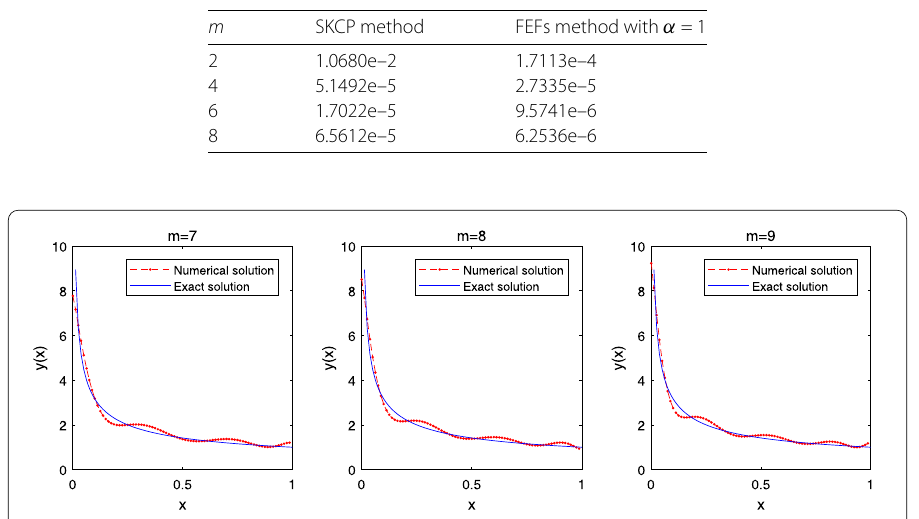
Figure 3 Comparisons of numerical solutions and exact solution of Example 4 for different m